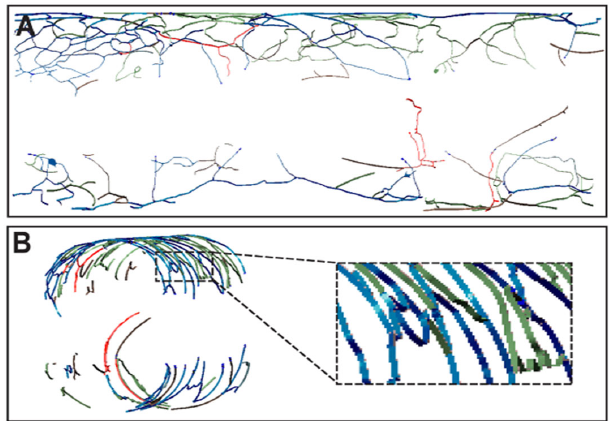
Figure 6. Preparation of the central portion of cylindrical colon pattern for printing . ( A ) Virtual sectioning of the CAD model in two horizontal semi ‐ cylinders. ( B ) Oblique view of the model, and selection of a portion for higher magnification to show the decomposition of the continuous lines in short segments ( insert